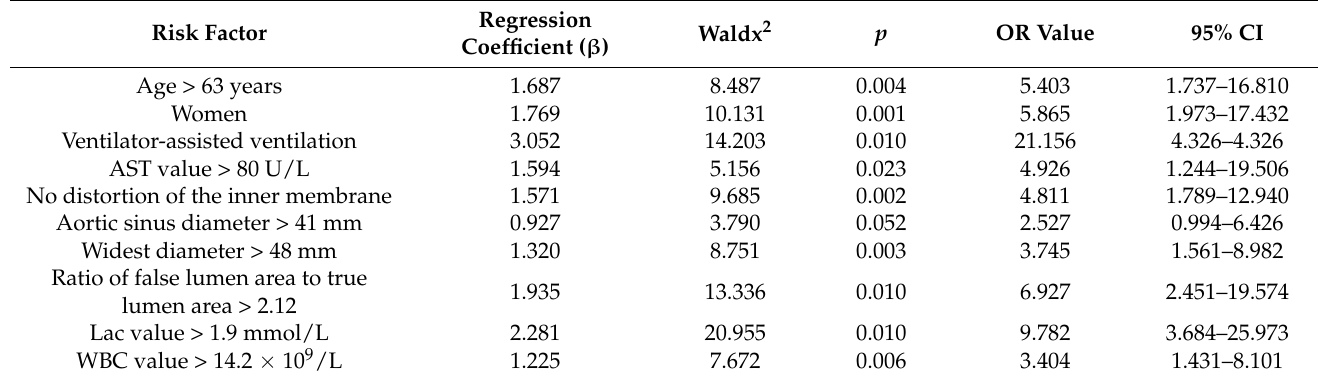
Table 2. Multivariate logistic regression analysis of risk factors for dissection rupture within 72 h after